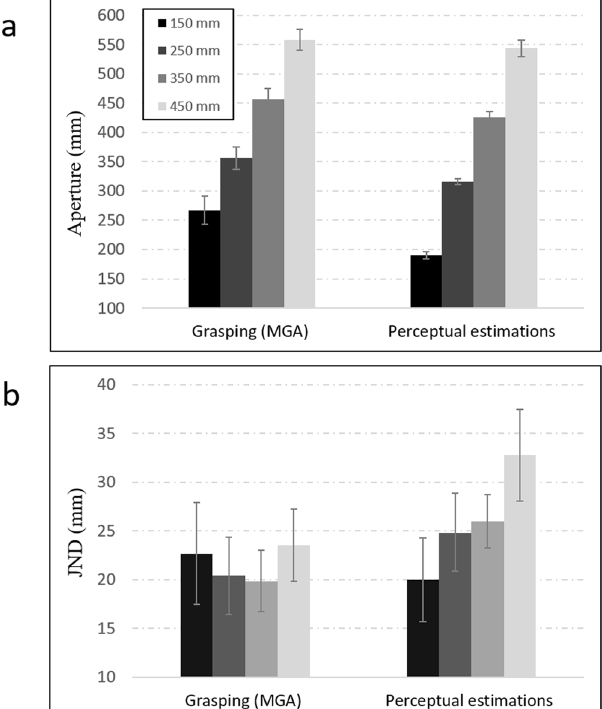
Figure 2. Average grip apertures ( a ) and JNDs ( b ) at the point of maximum grip aperture (MGA) for grasping and for perceptual estimations. Unlike perceptual estimations that adhered to Weber’s law, grasping trajectories did not increase with object size and were therefore immune to Weber’s law. Error bars represent standard errors of the